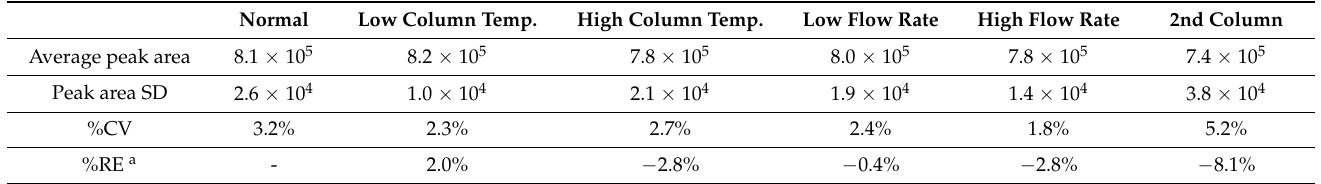
Table 5. Robustness data.